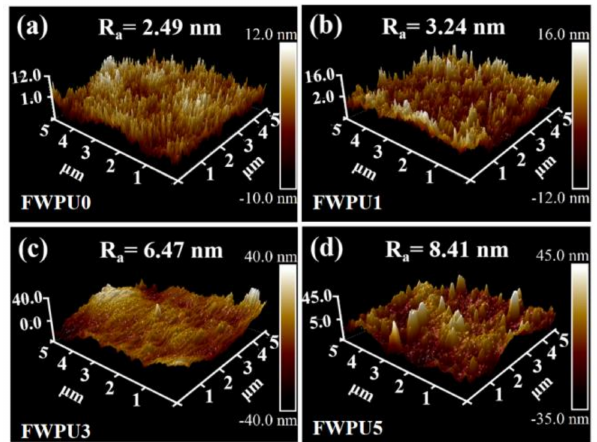
Figure 6. AFM images of FWPU films with different POSS contents, FWPU0 ( a ), FWPU1 ( b ), FWPU3 ( c ), FWPU5 ( d